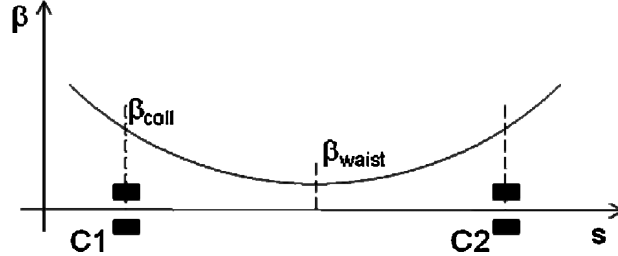
FIG. 1. Schematic of a two-stage CS with low- (cid:2) symmetric